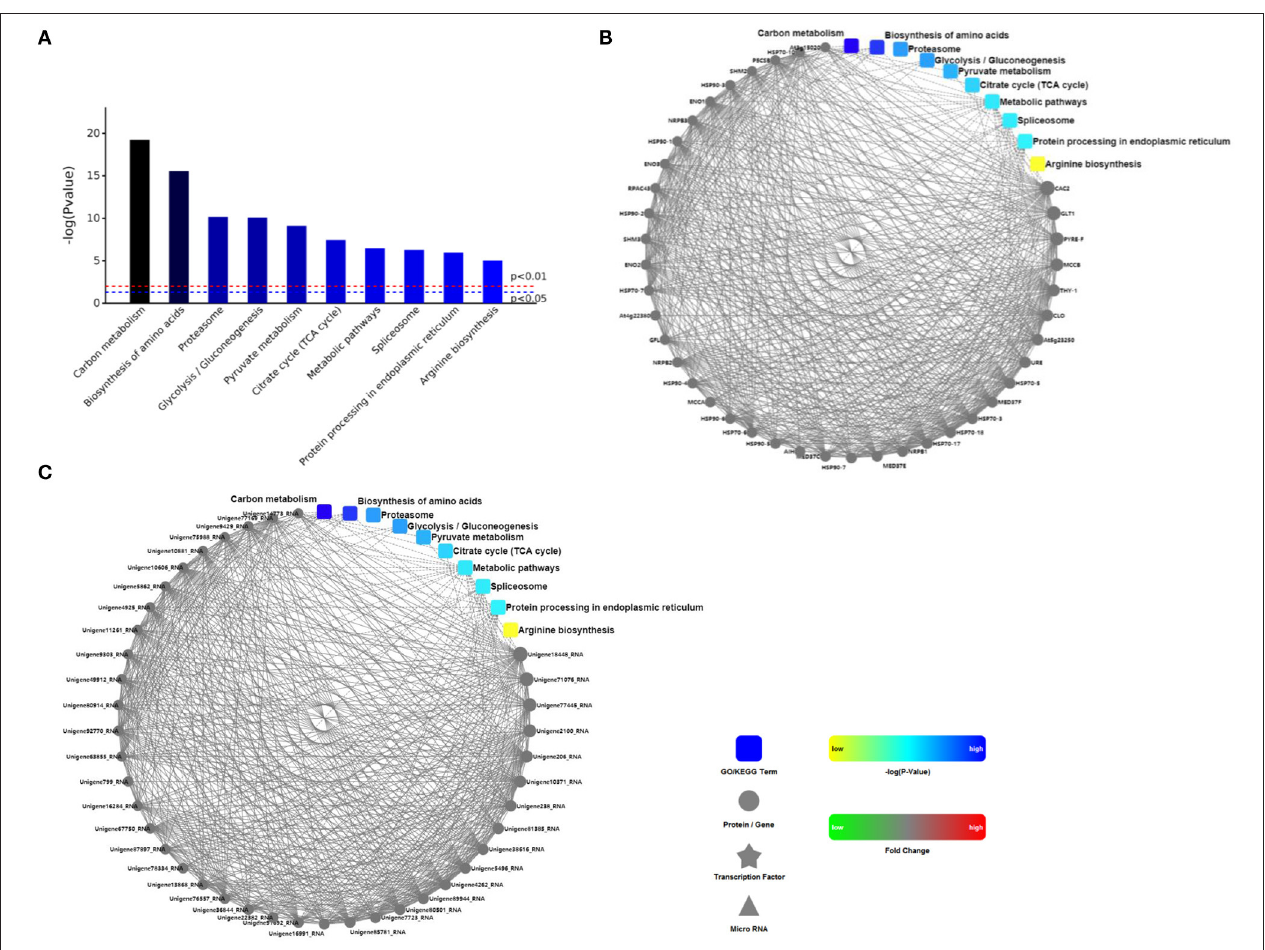
FIGURE 2 | The analysis of KEGG and PPI proteins in roots of R. glutinosa. (A) The significant top ranking 10 KEGG enrichments, (B, C) represents the interaction between the 10 regulatory pathways and the interaction with the protein, is respectively ppigene (B) and ppiquery (C) of interaction network. P value of red line and blue line in (A) is respectively 0.01 or 0.05, only when the top of the column is higher than the blue line or the red line, the regulatory pathway is significant ( P < 0.05) or very significant ( P < 0.01). Interactive mapping (B) or (C) is based on dots (gene or protein), polygon (metabolic product), triangle (miRNA), five angle (transcription factor) and rounded rectangle (biological process, cellular localization, molecular functional or signaling pathway) connecting lines, which show the molecular interaction networks and connection mechanism model. The dashed line is without the experimental verification, the solid line is already the relevant verification reports. Furthermore, the dot color change is that red sketch expression is up-regulated, green sketch expression is down-regulated, the rounded rectangle color is that yellow and blue gradient said is from low to